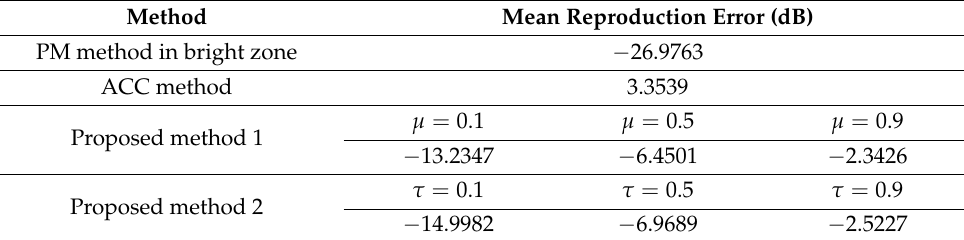
Table 10. Mean normalized spatial average error of different methods relative to frequency for two-dimensional experiment with sparse sampling